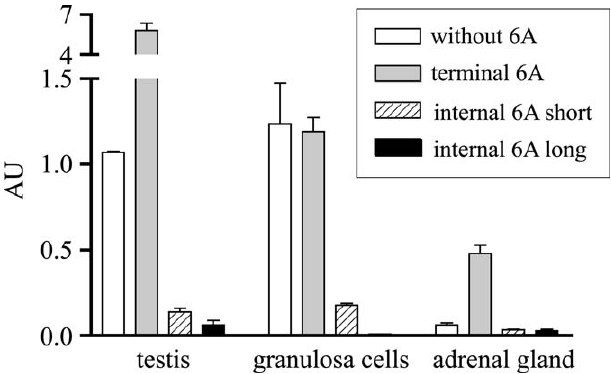
Figure 3. Tissue-Specific Expression of Exon 6A mRNA Quantification of LHCGR transcripts in different human tissues by TaqMan RT-PCR. mRNA extracted from human testes and granulosa cells and from a commercially available adrenal gland preparation was analyzed. After normalization against 18S RNA, results were quantified with the testis transcript without exon 6A as the reference that was assigned an arbitrary unit (AU) value of 1. Results are shown as mean 6 SEM of three independent experiments. The amplicon without exon 6A represents the transcript that results in the mature, full-length LHCGR protein. Transcripts containing the terminal exon 6A are highly expressed in all tissues analyzed and show a 6-fold higher expression compared to those without exon 6A in testis and adrenal gland. In comparison, the expression level of the internal exon 6A transcripts is much lower in every tissue.